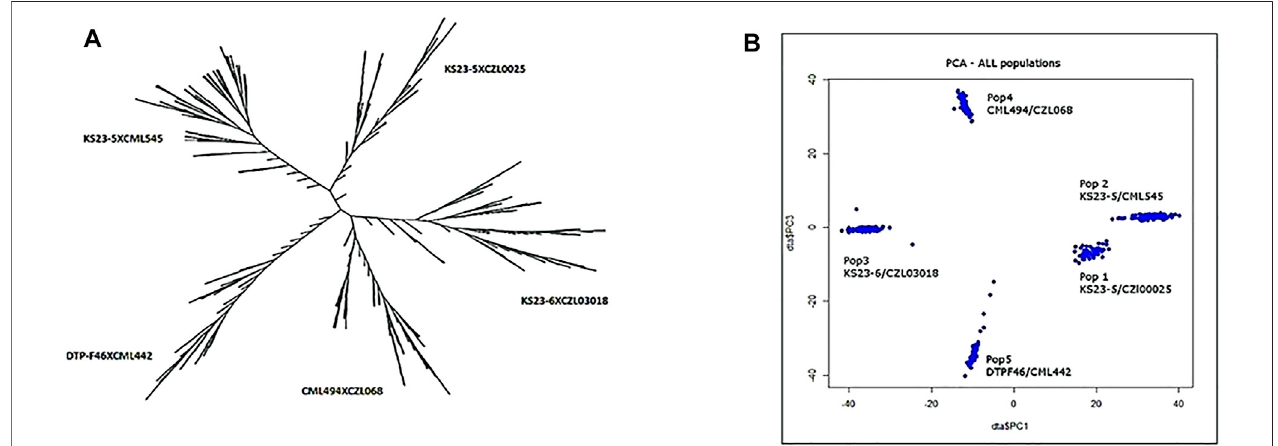
FIGURE 4 | Clustering pattern of 438 genotypes forming fi ve populations using UPGMA method (A) and grouping of the genotypes using the fi rst three PCs (B)